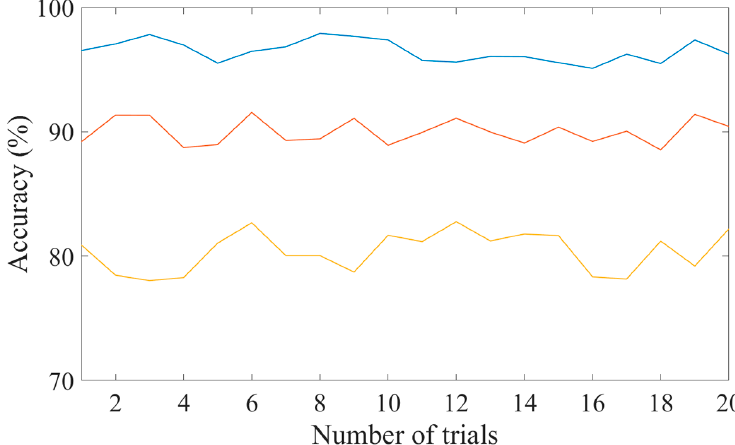
Figure 15. Accuracies of the datasets C using the three methods.